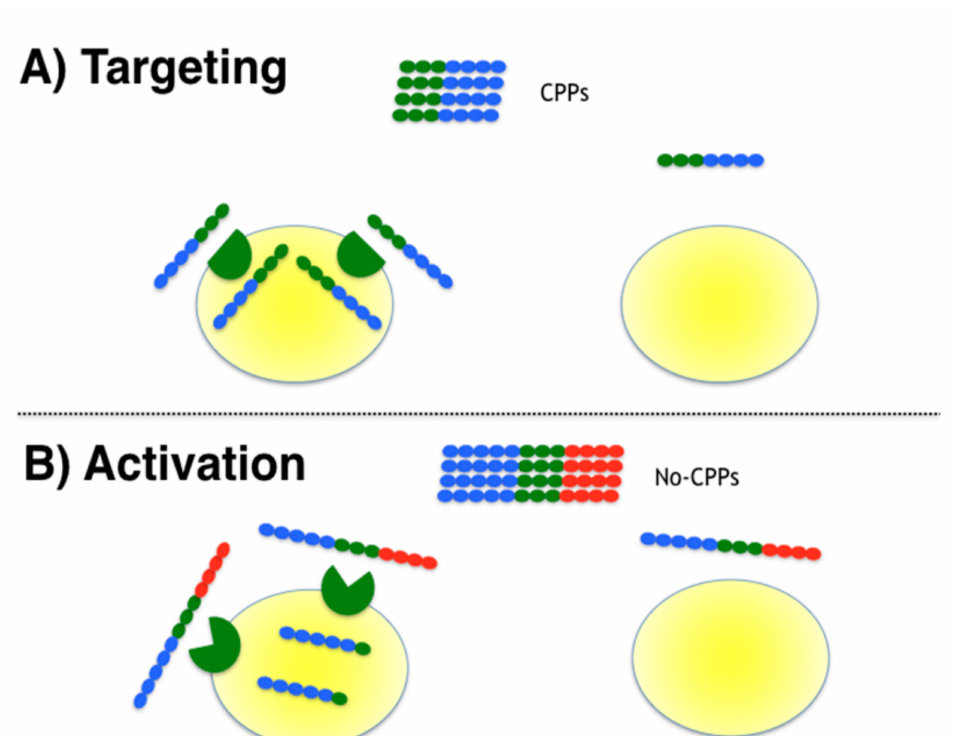
Figure 1. Strategies to provide selectivity to CPPs. Two strategies were tested to provide selectivity to CPPs, namely targeting and activation. The CPP sequence in blue, non-CPP conferring function sequence in red and ligand and cleavage site in green for ( A ) targeting and ( B ) activation,